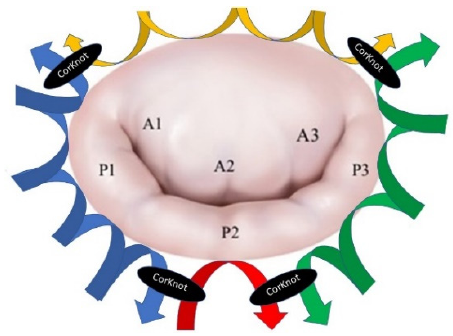
Figure 2. The annuloplasty technique.